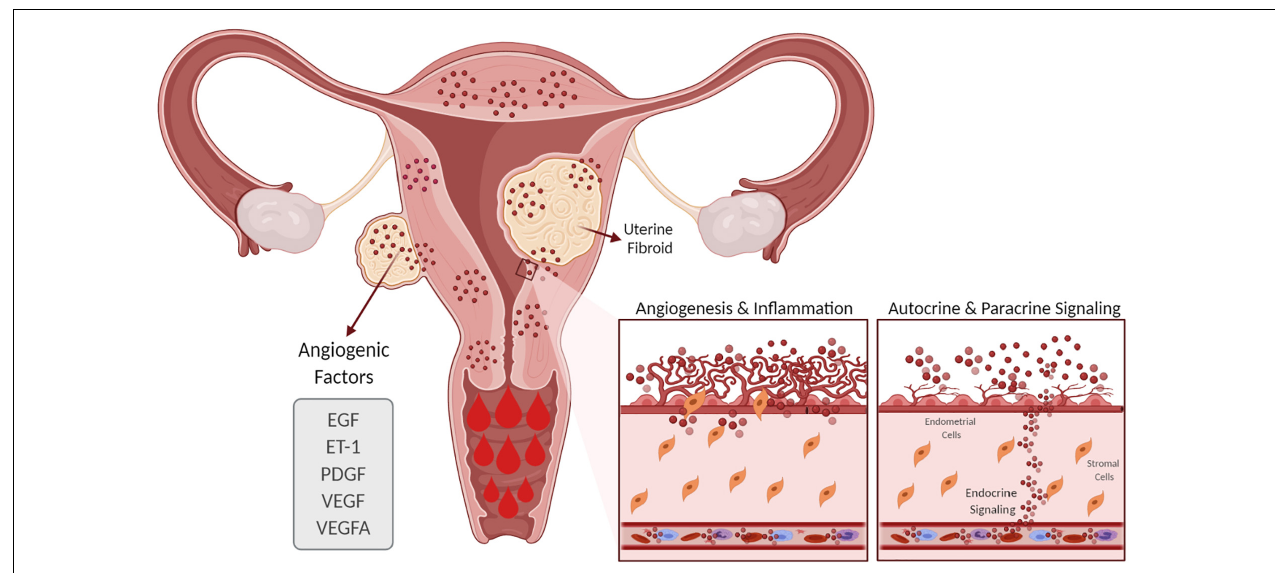
FIGURE 3 | Effect of uterine fibroids (UFs) on heavy menstrual bleeding. The presence of UFs causes alterations in the endometrial vascular architecture and function, contributing to increased and prolonged menstrual bleeding. UFs influence the production of angiogenic factors such as VEGF, VEGFA, ET-1, EGF, and PDGF, among others, which support increased angiogenesis. EGF , epidermal growth factor; ET-1 , endothelin 1; PDGF , platelet-derived growth factor; VEGF , vascular endothelial growth factor; VEGFA , vascular endothelial growth factor A.